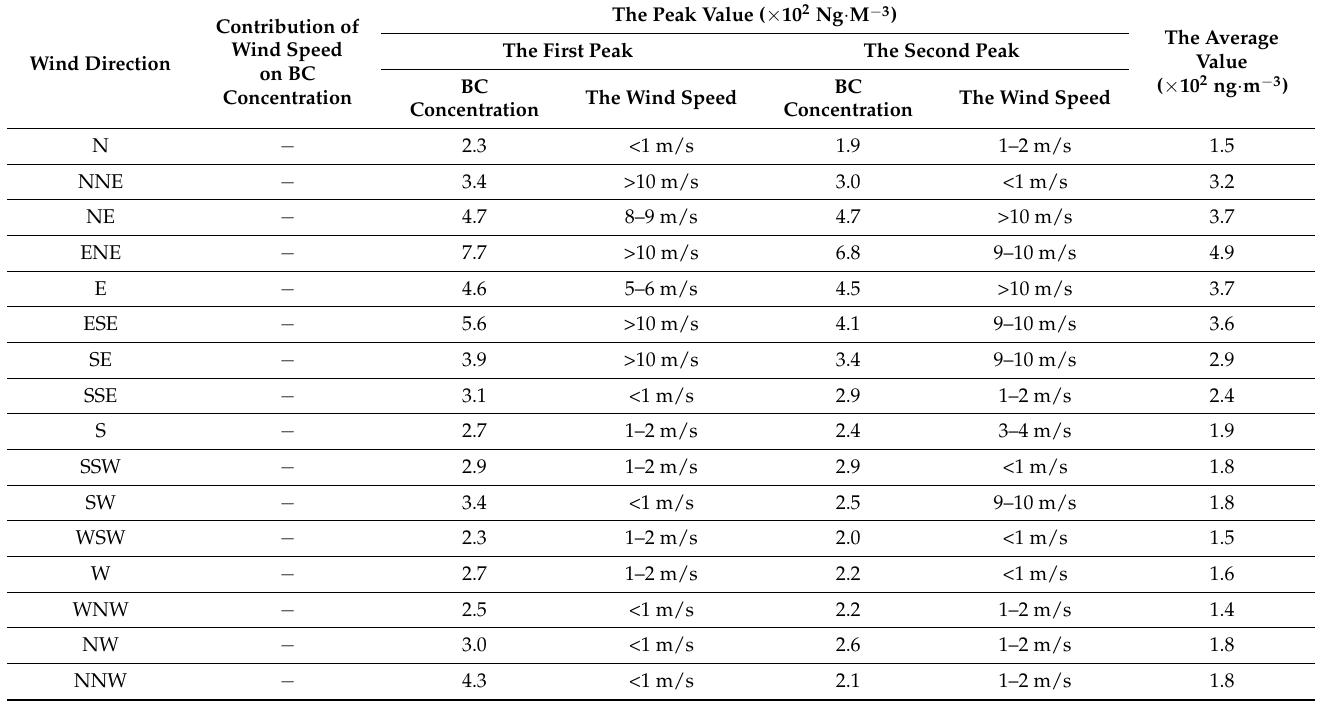
Table 1. The data comparison between wind speed/direction and black carbon